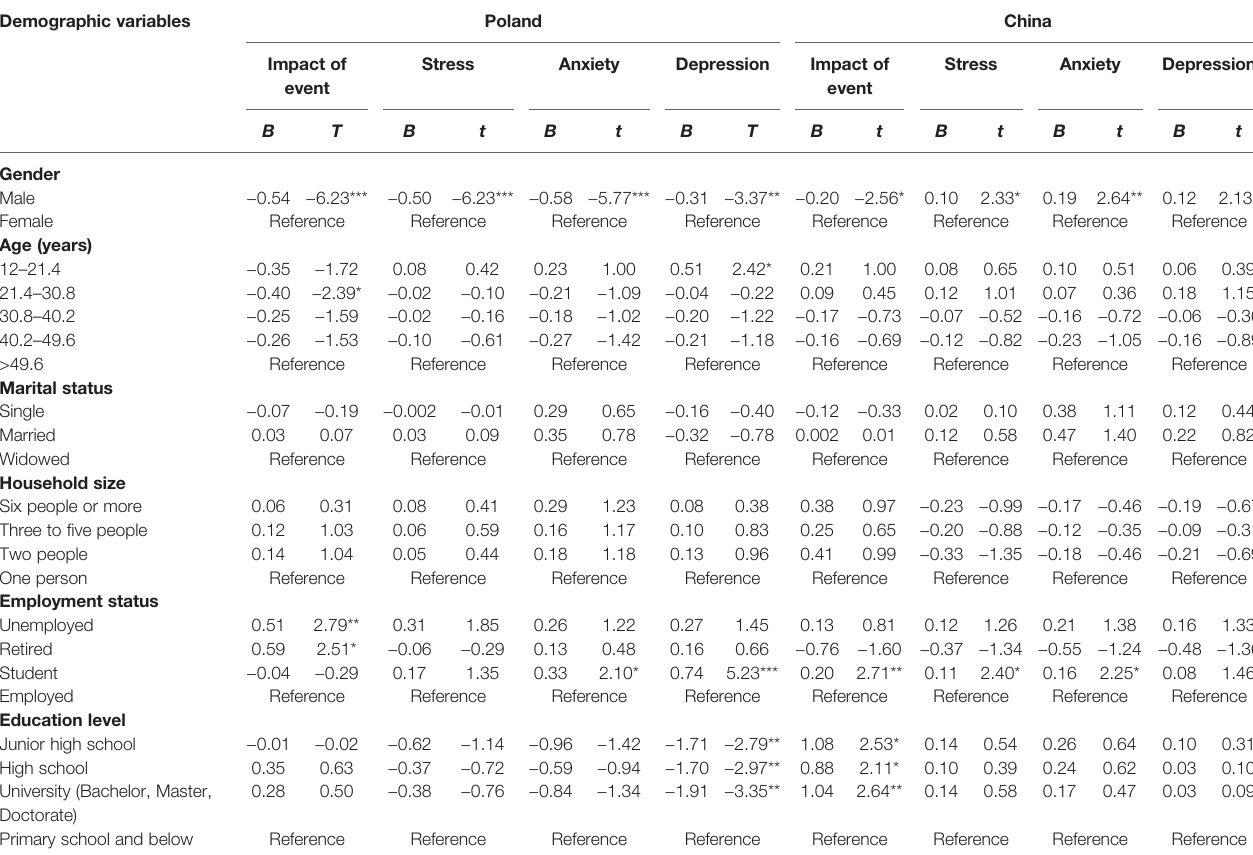
TABLE 2 | Association between demographic variables and the psychological impact of the 2019 coronavirus disease (COVID-19) outbreak as well as adverse mental health status between Polish and Chinese respondents during the epidemic (N = 2,266). Demographic